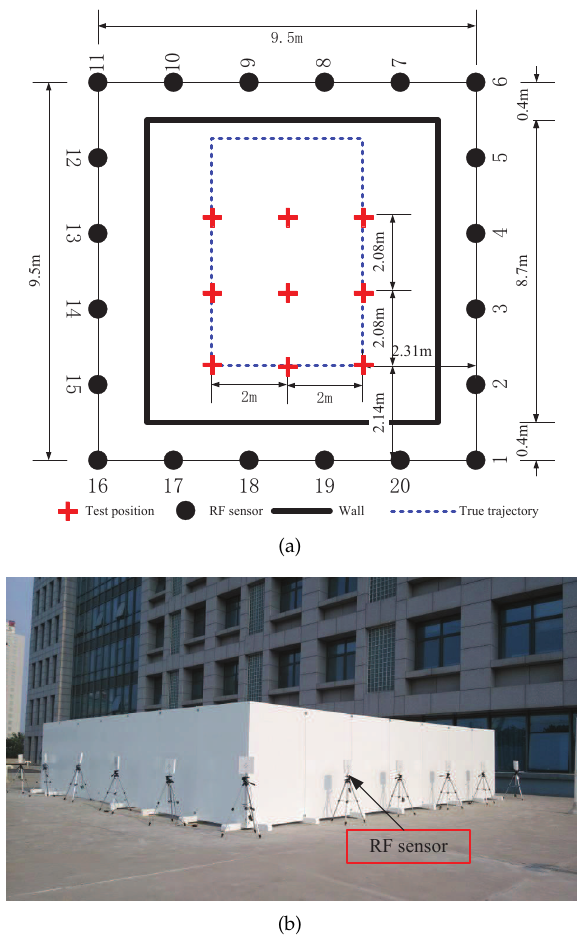
Figure 7. The outdoor experimental environment: ( a ) a sketch of the experimental layout and ( b ) photography of the experimental environment.